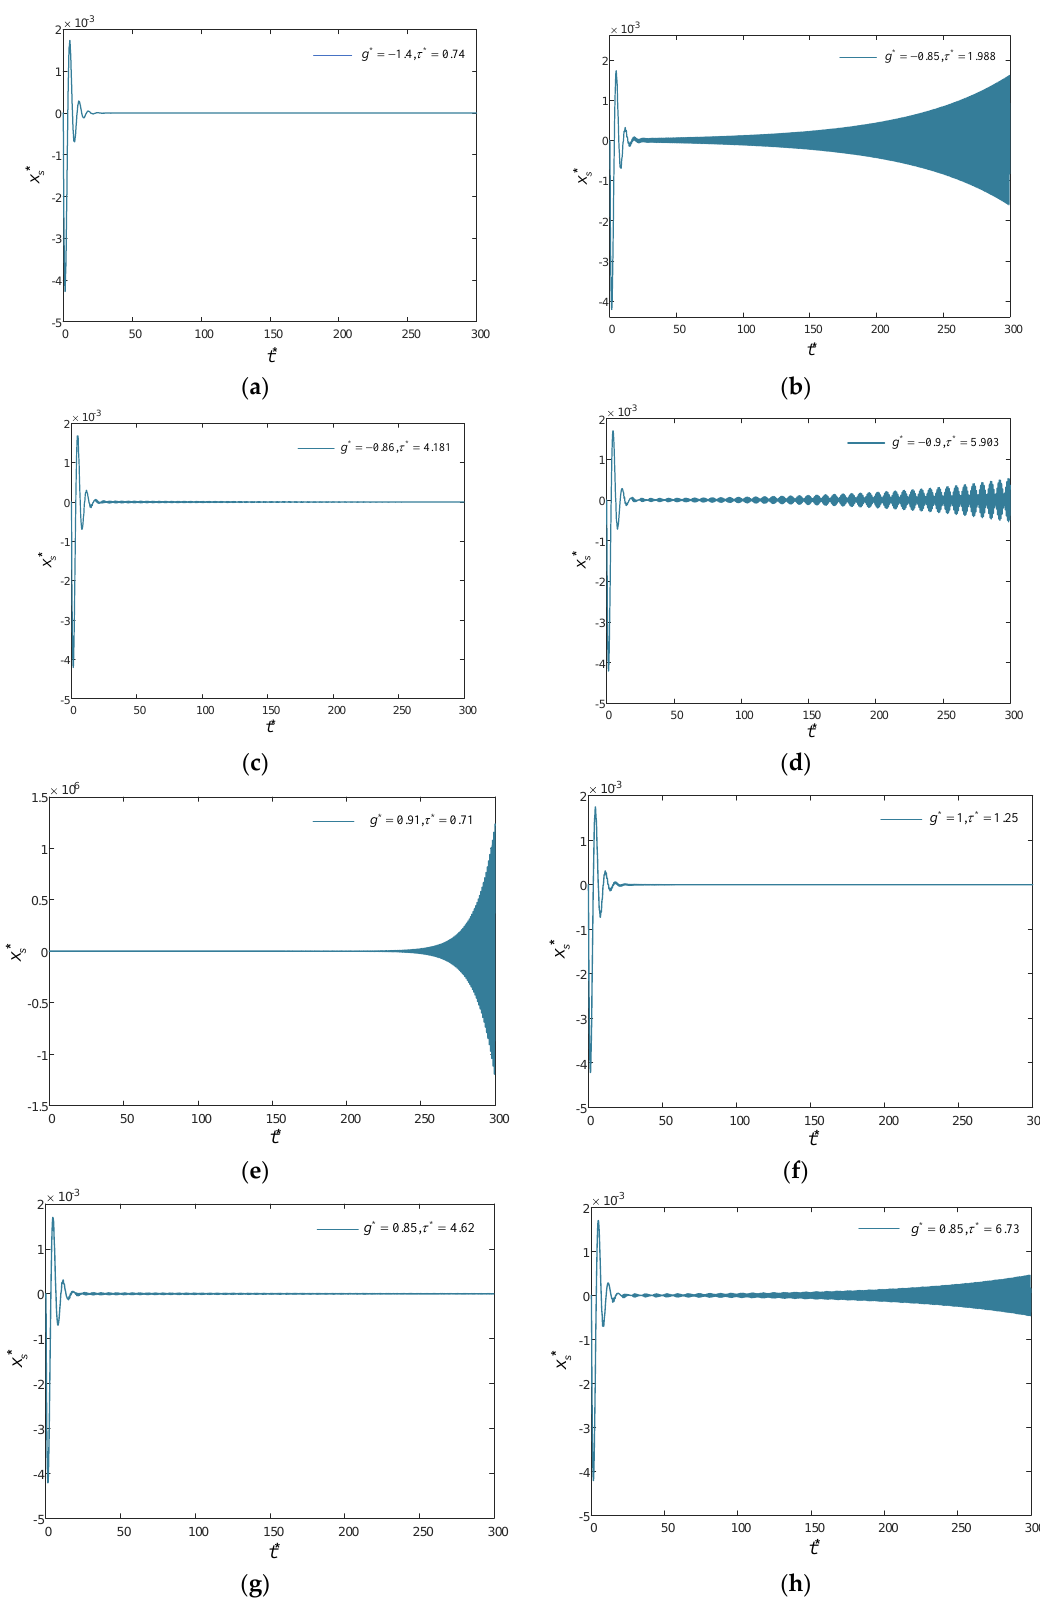
Figure 5. System stability verification: ( a ) P 1 ( g ∗ = − 1.4, τ ∗ = 0.74 ) ; ( b ) P 2 ( g ∗ = − 0.85, τ ∗ = 1.988 )